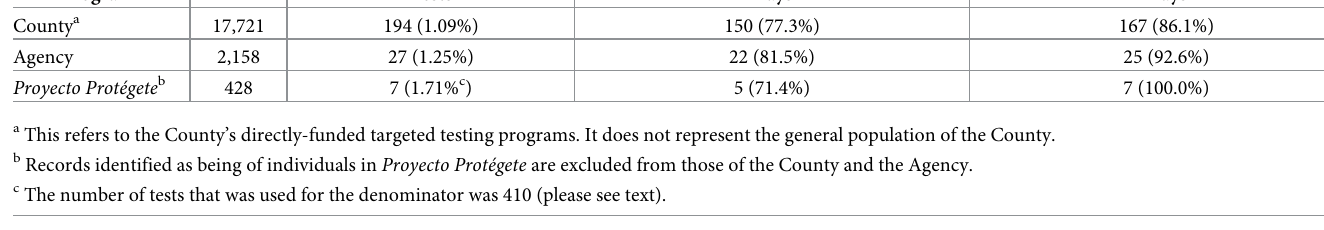
Table 2. HIV tests, confirmed new HIV-positive tests, and individuals linked to medical care within 30 and 90 days among Latino MSM, 18 years or older at time of test for the county, the agency and Proyecto Protégete . HIV Testing HIV Tests Confirmed New HIV-Positive Program